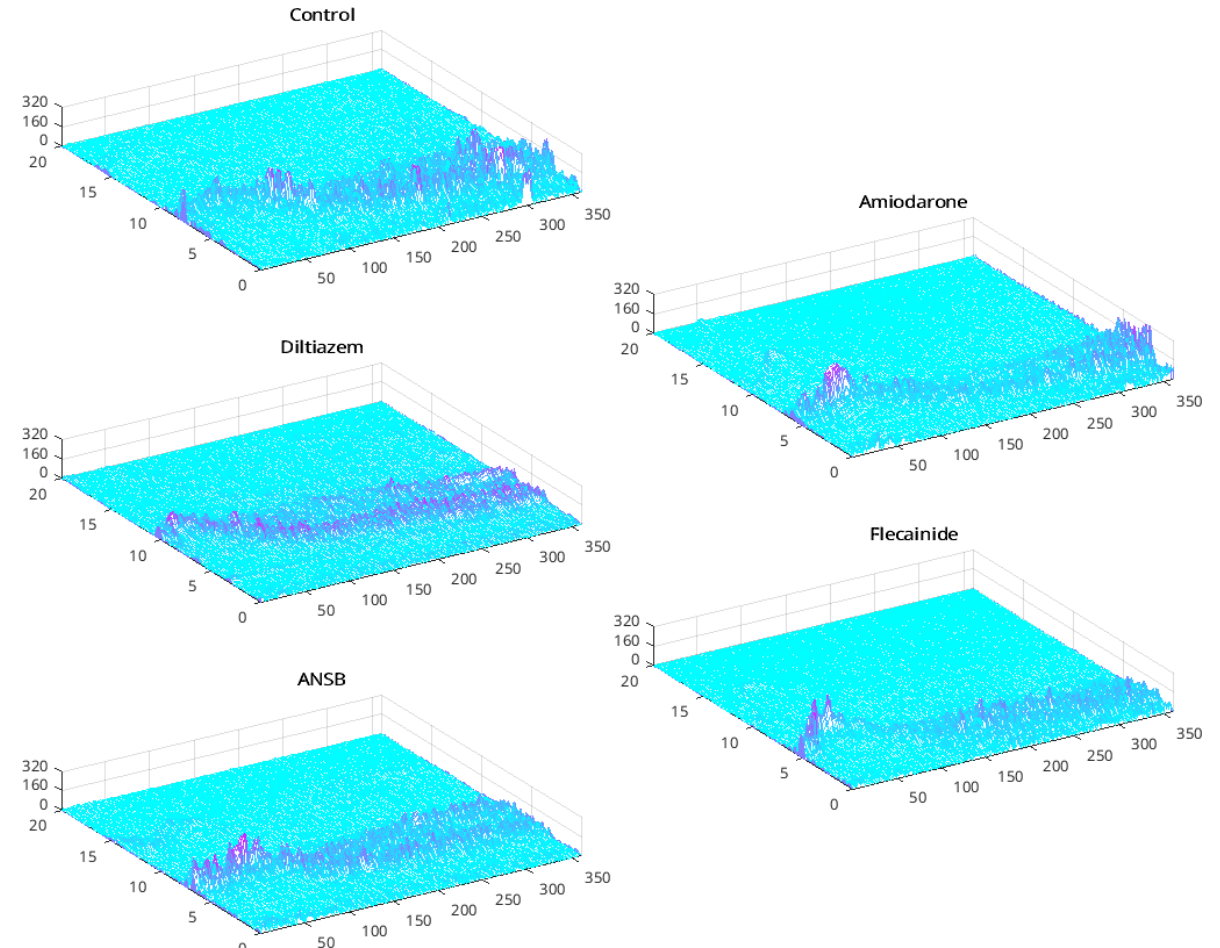
Figure 2. Short-Time Fourier Transform for rectangular windows of size 2048 samples (about 2 s) for several examples of VF signals on the different states and interventions of the experimental